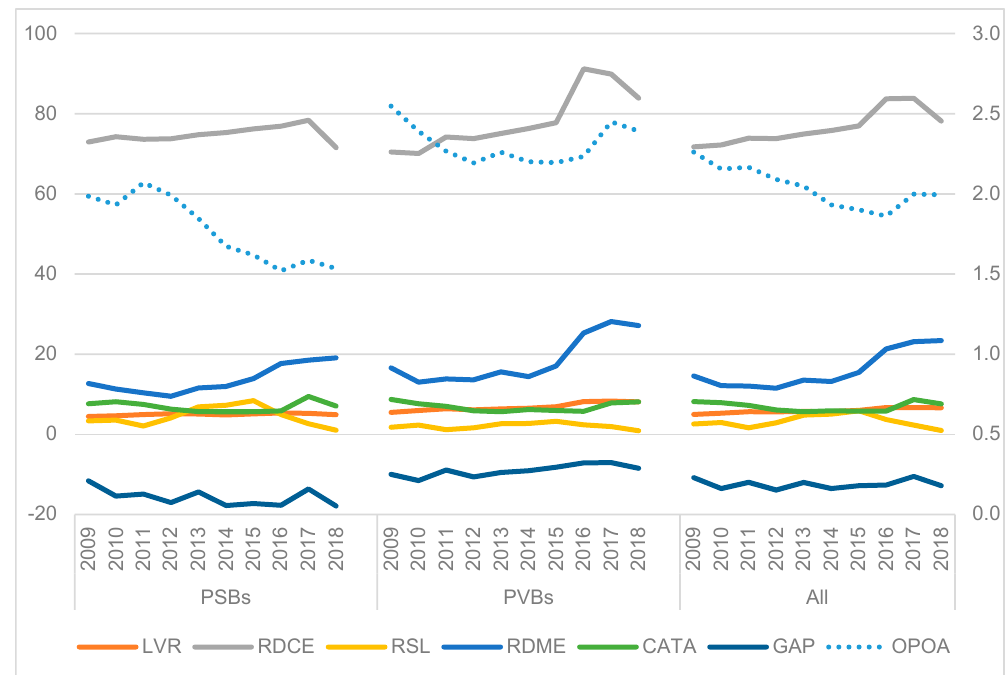
Figure 1. Return and Risks: Bank Groups. Source: Author’s calculation.